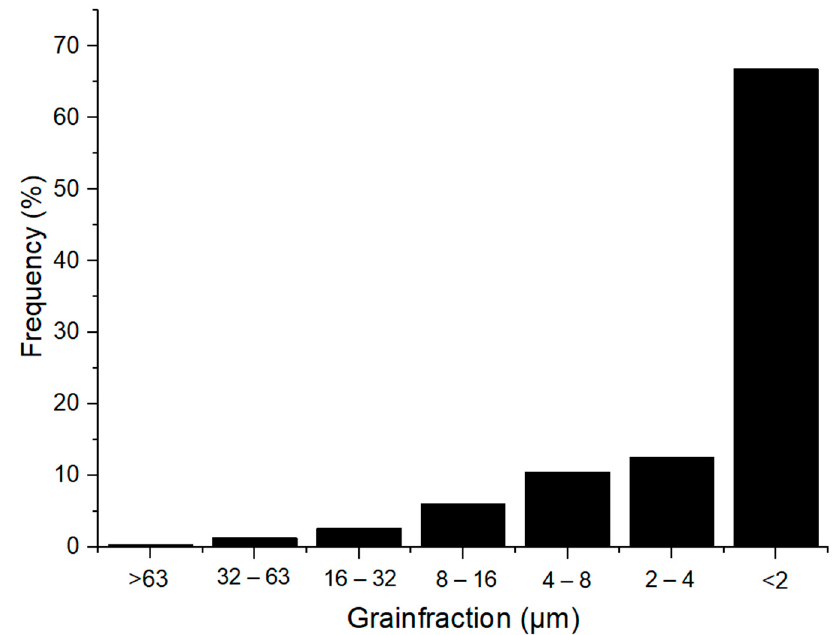
Figure 2. Granulometric curve of Borkowice clay [10].